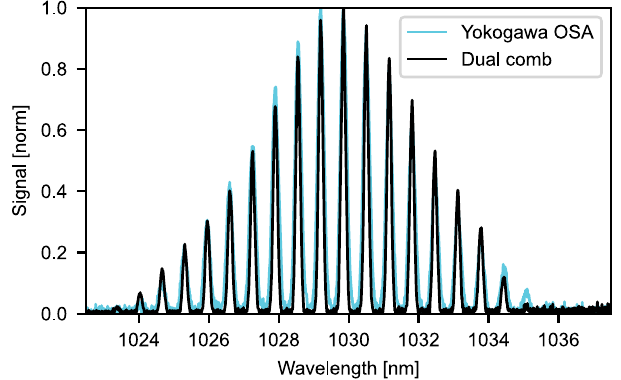
Fig. 7 Comparison of the Fabry – Pérot etalon spectrum measured with the OSA and dual-comb setup. The dual-comb spectrum was obtained from a single 80 µ s interferogram time-trace. The width of the transmission line is 24 GHz.